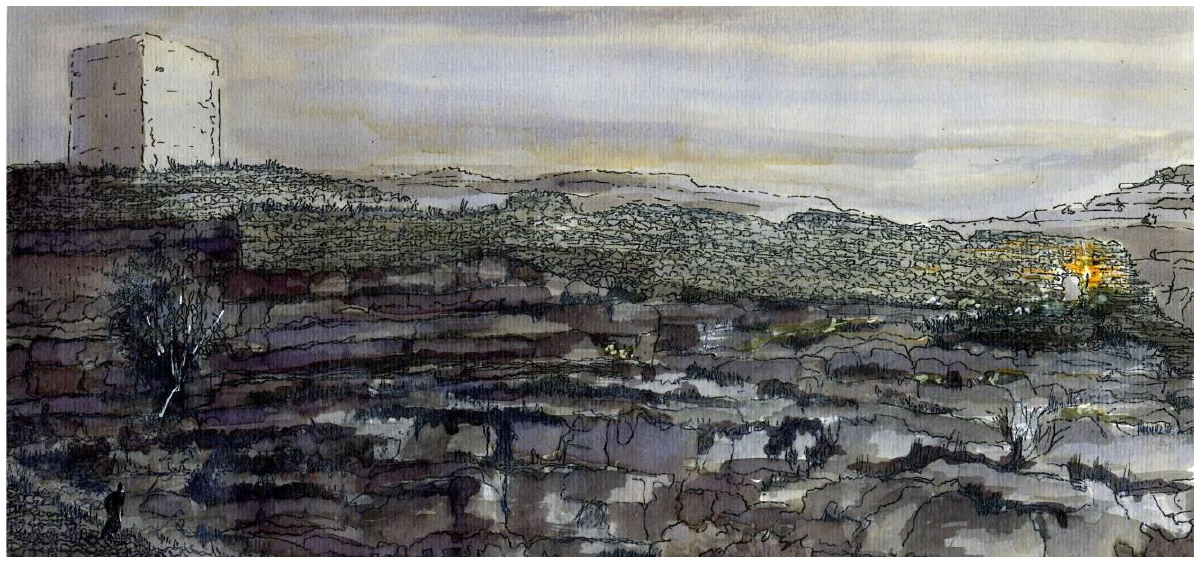
Figure 10. Sketch of the wall and its surroundings (J.